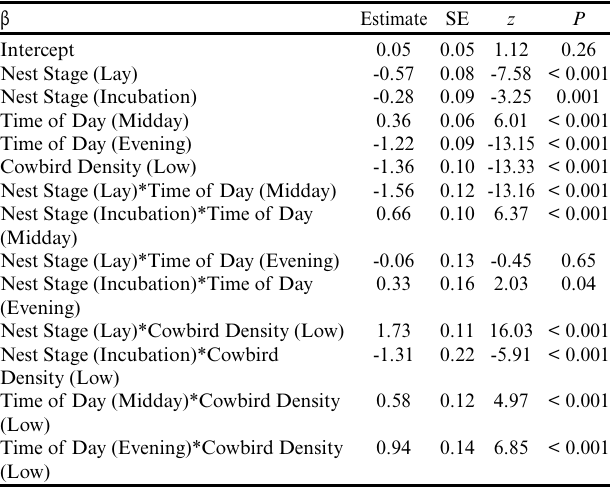
Table 8. Parameter estimates for the best model assessing the parasite-assessment hypothesis and the relationship between vocalization rate by male vireos and nest stage (Stage), time of day (Time), and local cowbird density